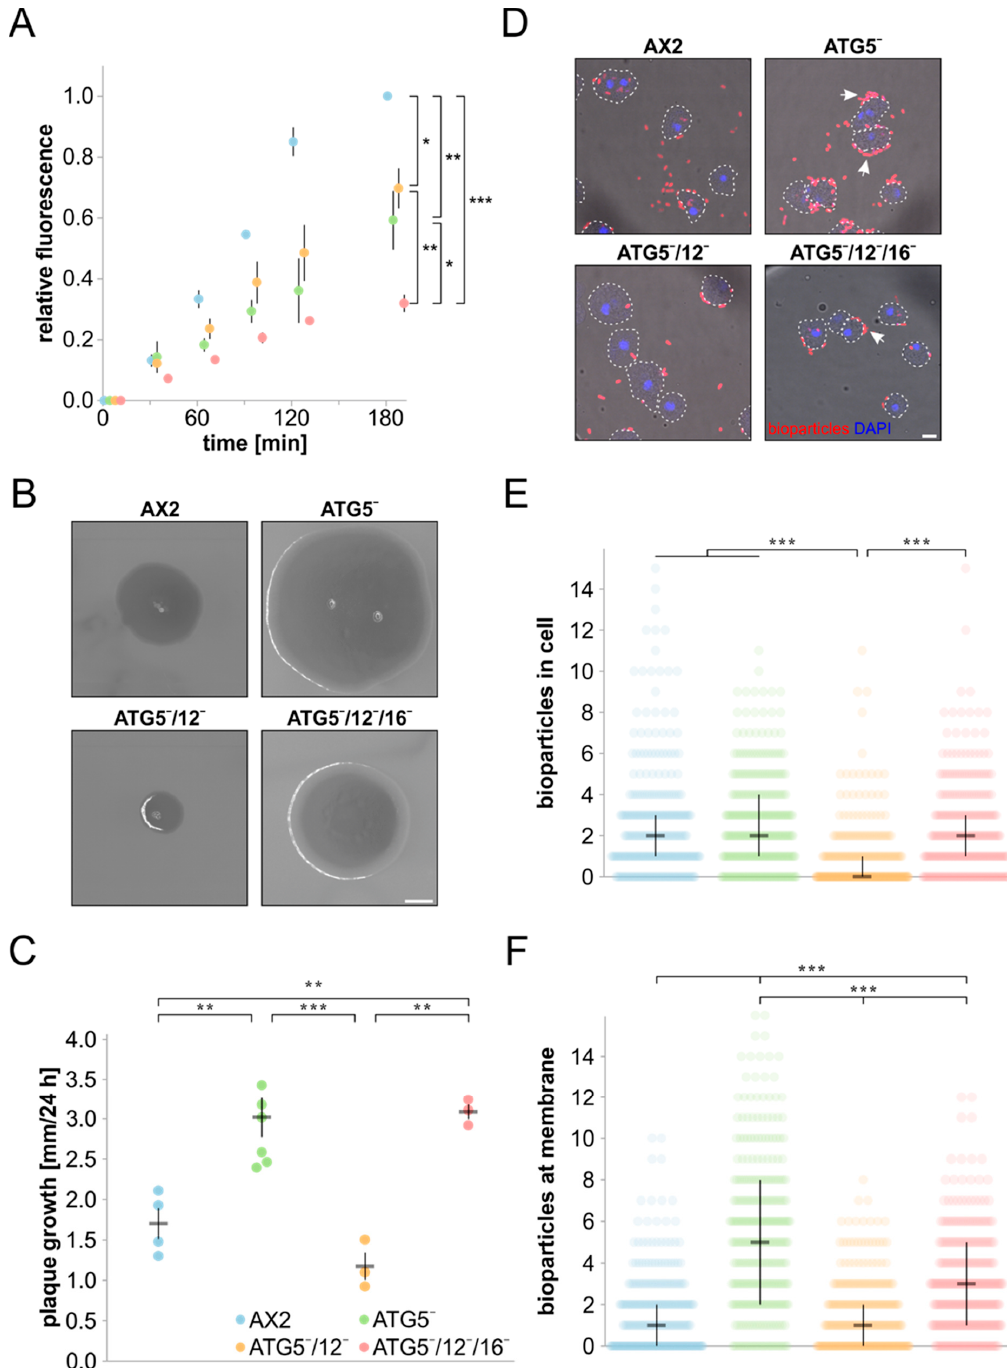
Figure 6. Phagocytosis of yeast and bacteria by AX2 and mutant strains. ( A ) Phagocytosis of TRITC-labelled yeast. AX2, ATG5¯, ATG5¯ / 12¯ and ATG5¯ / 12¯ / 16¯ cells were adjusted to 6 × 10 6 cells / mL and co-incubated with a six-fold excess of TRITC-labelled yeast for 180 min. Color assignment of strains is as in panel C. Analysis was done as for macropinocytosis (see Figure 5B). ( B ) Growth on K. aerogenes . Representative images of plaques formed by AX2, ATG5¯, ATG5¯ / 12¯ and ATG5¯ / 12¯ / 16¯ cells after 96 h growth on a lawn of K. aerogenes. Scale bar is 1 mm. ( C ) Quantitation of plaque growth for AX2, ATG5¯, ATG5¯ / 12¯ and ATG5¯ / 12¯ / 16¯ cells. Three days after plating the cells, plaque diameters were determined every 24 h for five days and the average growth per 24 h was calculated. Mean